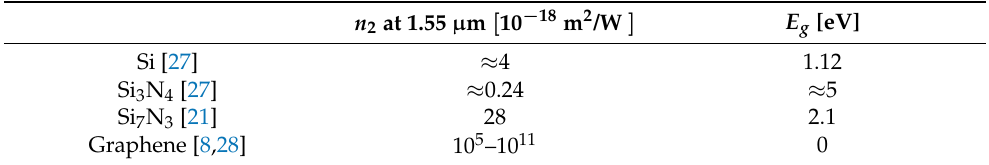
Nonlinear refractive index of silicon, silicon-rich nitride, ultra silicon-rich nitride, and